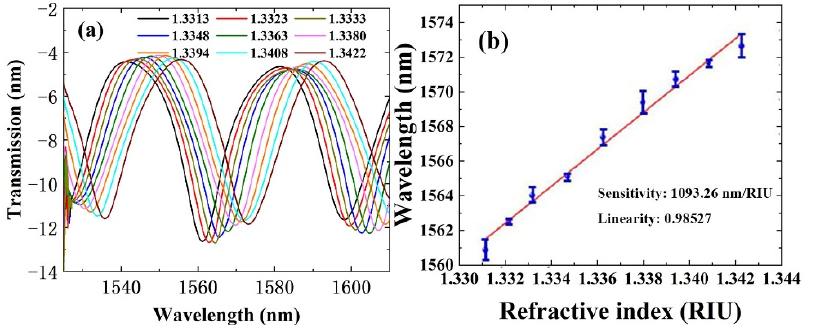
Figure 3. Refractive index sensing performance of a UV-glue-coated-microfiber. ( a ) Spectra change as a function of refractive index change from 1.3313 to 1.3422 and ( b ) corresponding sensing characteristics curve.